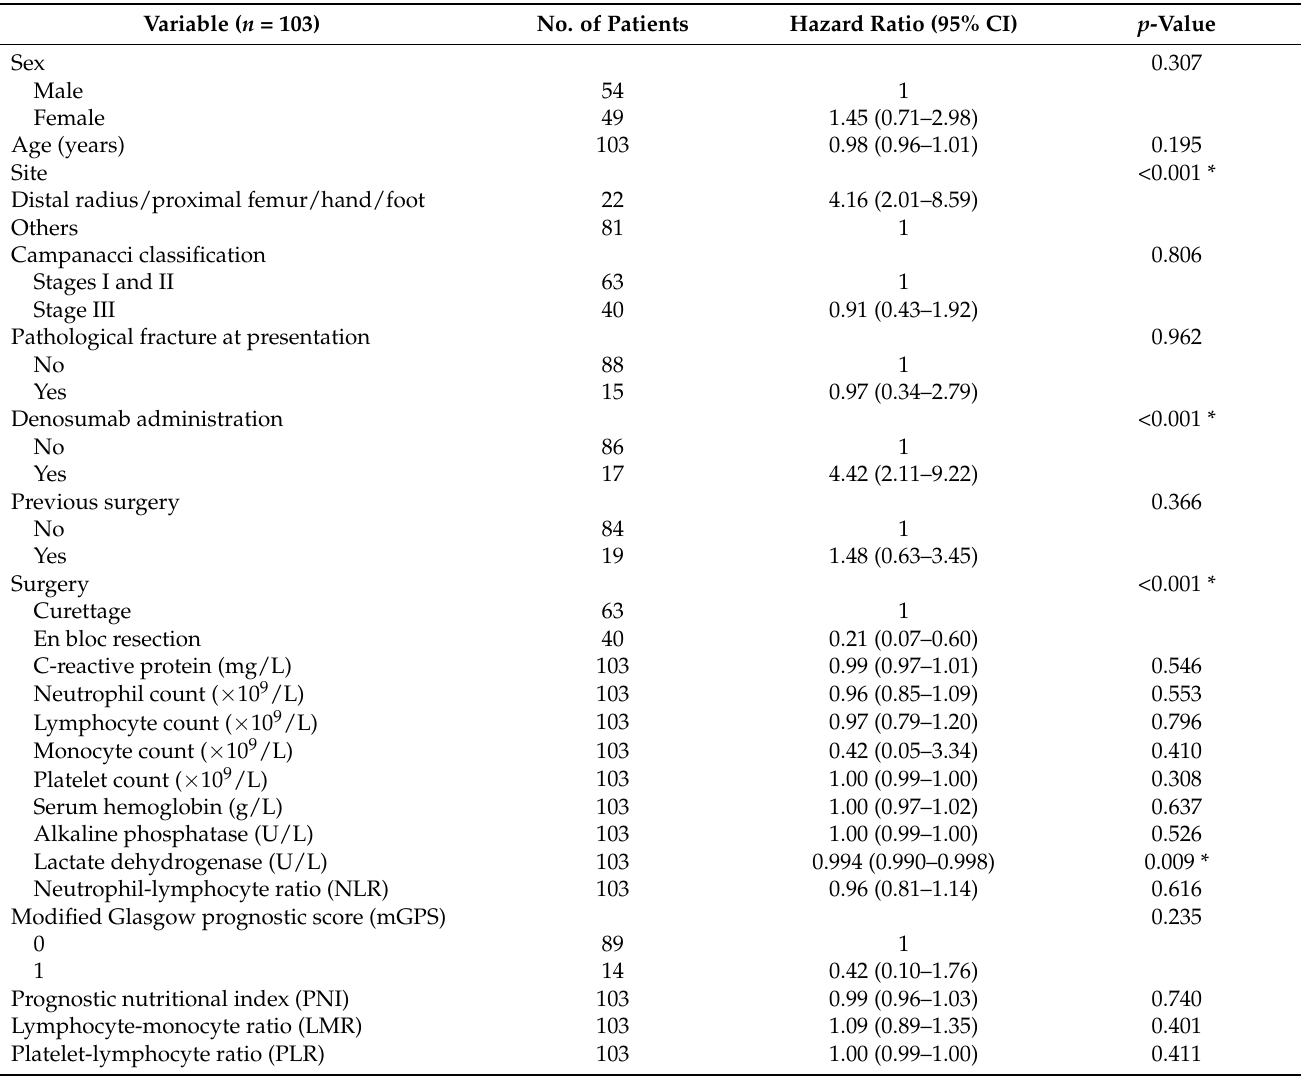
Table 2. Univariate Cox regression analysis of local recurrence-free survival.